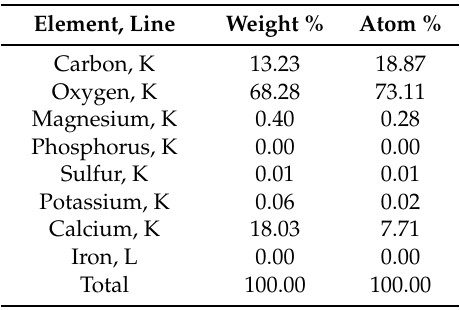
Table 6. EDX analysis of the precipitate shown in Figure